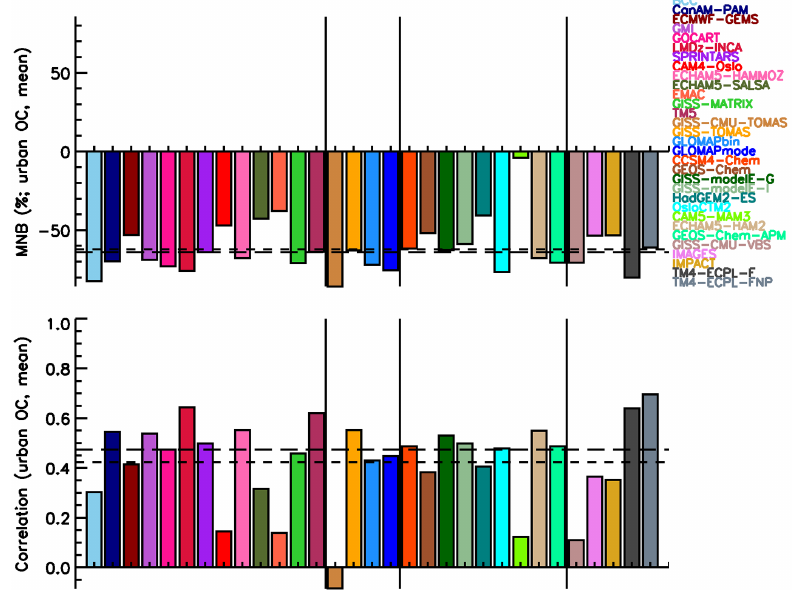
Figure 10. Mean normalized bias (top) and correlation (bottom) of all models with urban OC measurements. When more than one mea- surement data point exists in a model grid, the corresponding mean of the measurements was used (see text). The mean across all models is shown with the short-dashed line, and the median with the long-dashed line. The perfect model has MNB = 0 and correlation = 1. The models are grouped like in Fig. 2.